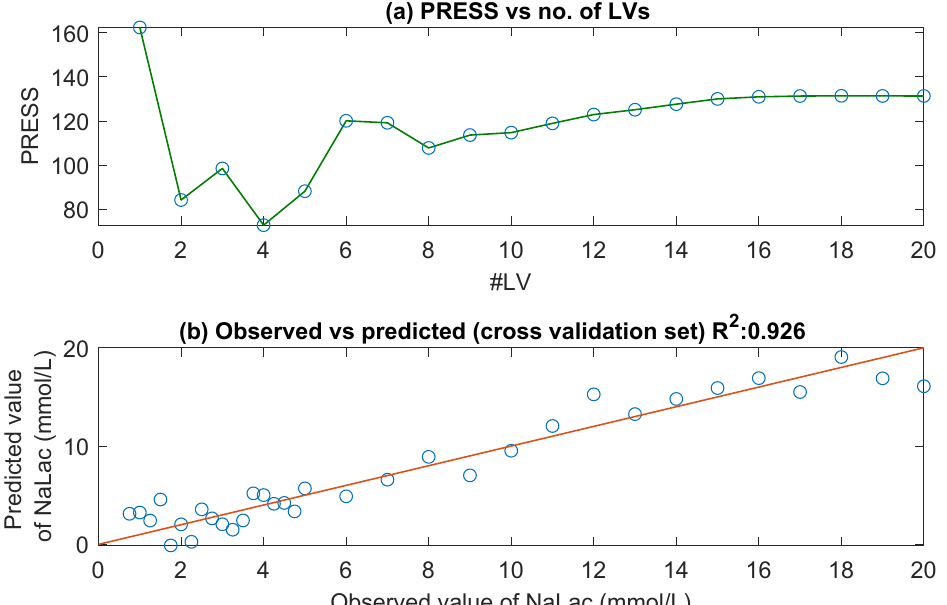
Figure 2. Depicts ( a ) the graph of Prediction Error Sum of Squares (PRESS) versus the number of latent variables (LVs) for UV/visible spectra. The optimal number of LVs used for building the PLS model was two, and ( b ) predicted NaLac concentration vs. the reference NaLac concentration of thirty-seven PBS samples. The correlation coefficient (R 2 ) and root mean square error of cross-validation (RMSECV) were 0.926 and 1.59 mmol/L,